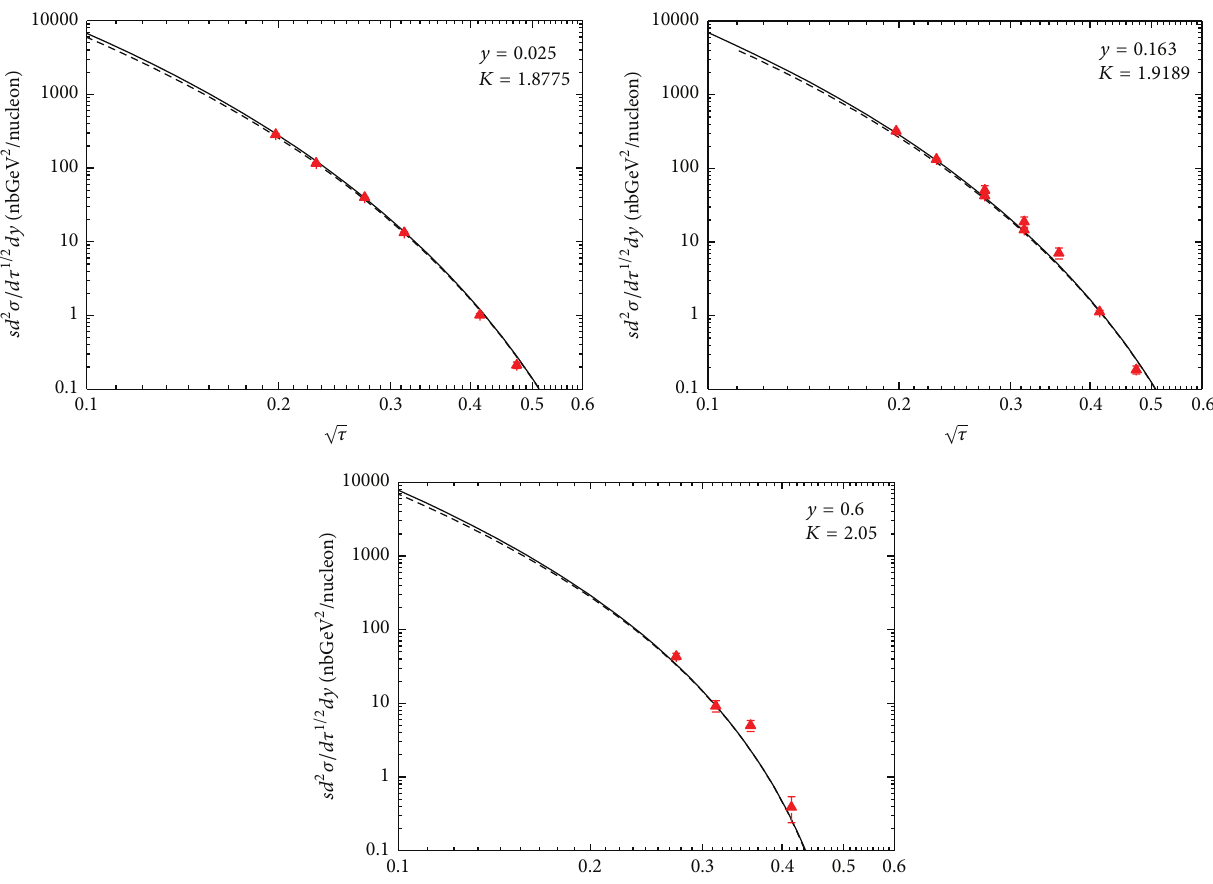
Figure 10: Dileptons production cross section for p-Pt collision in terms of √𝜏 according to (13) for 𝑦 = 0.025 , 0.163, and 0.6 and √𝑠 = 38.8 GeV. The full curve is obtained by considering the pionic contribution and the dashed line is plotted without considering the pionic contribution. The used 𝐾 factor has been indicated in each graph. The difference between full and dashed lines is about 3–6%. The experimental results have been taken from